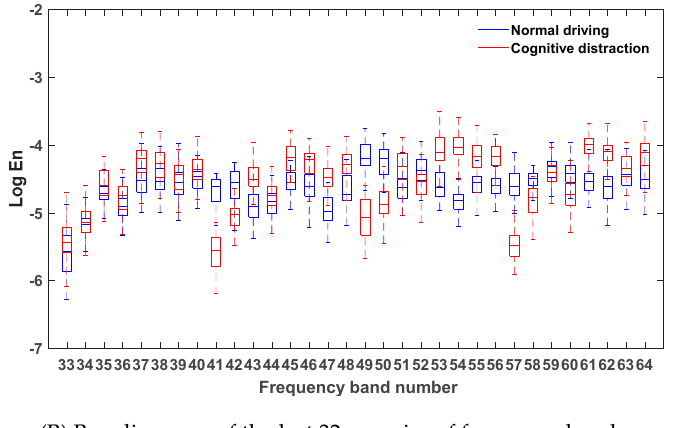
Figure 7. Box diagrams of the energies of the frequency bands under different driving states.